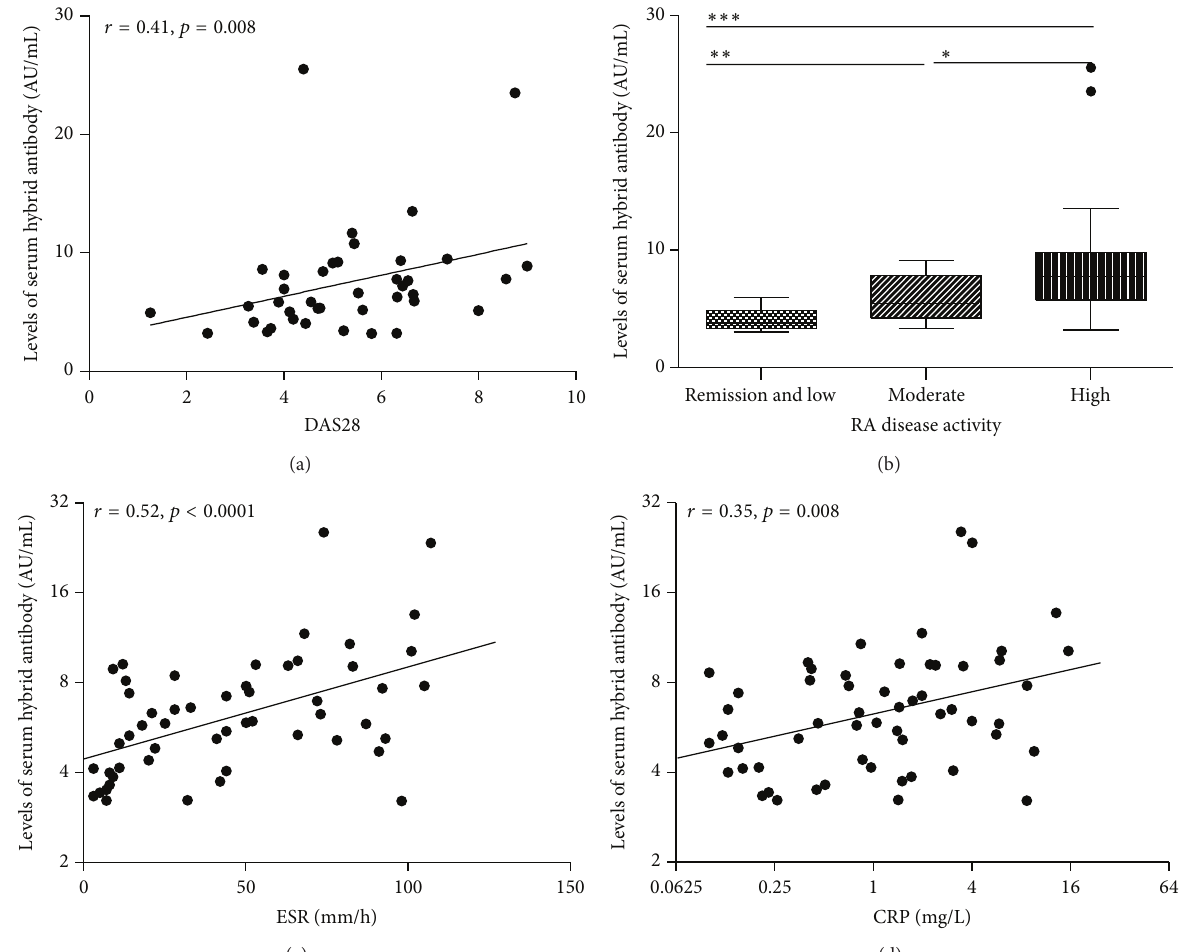
Figure 4: The relationship between serum levels of 𝜅 / 𝜆 hybrid antibody and disease activity in RA. (a) Levels of 𝜅 / 𝜆 hybrid antibody in the serum of RA patients positively correlated with DAS28 ( 𝑟 = 0.41 , 𝑝 = 0.008 ). (b) The distribution of 𝜅 / 𝜆 hybrid antibody in RA patients with different disease activity status; RA disease activity on the basis of DAS28 was defined as follows: remission and low = DAS28 < 3.2 ( 𝑛 = 10 ), moderate = DAS28 between 3.2 and 5.1 ( 𝑛 = 16 ), and high = DAS28 > 5.1 ( 𝑛 = 22 ); the 𝜅 / 𝜆 hybrid antibody levels were significantly higher in the high and moderate disease activity groups than in the low disease activity and remission groups ( 𝑝 = 0.008 and 𝑝 = 0.0008 , resp.); the differences of 𝜅 / 𝜆 hybrid antibody levels between groups were assessed using the Mann-Whitney 𝑈 test, ∗ 𝑝 < 0.05 , ∗∗ 𝑝 < 0.01 , and ∗∗∗ 𝑝 < 0.001 . (c, d) Levels of 𝜅 / 𝜆 hybrid antibody in the serum of RA patients correlated with ESR ( 𝑟 = 0.52 , 𝑝 < 0.0001 ) and CRP ( 𝑟 = 0.35 , 𝑝 = 0.008 ). Concentrations of 𝜅 / 𝜆 hybrids antibody are presented in arbitrary units (AU/mL). Symbols represent individual subjects. Correlations were determined by Spearman’s rank correlation coefficients with 95% confidence